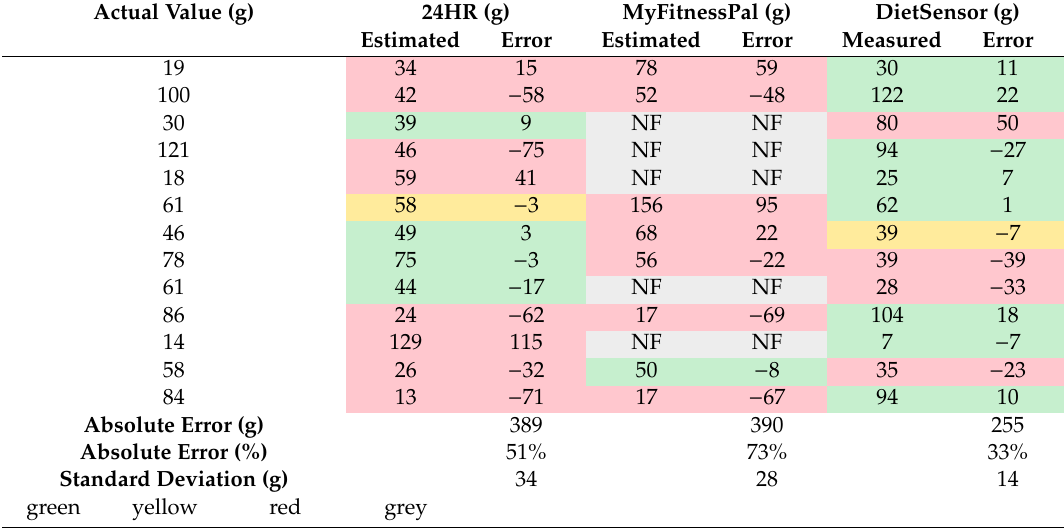
Table 1. The actual volume for each meal, along with the observed and absolute error for each method, in grams (g). For each trial, cells highlighted in green are the best result (lowest error) out of the three methods (DietSensor, 24HR, and MyFitnessPal). Cells highlighted in yellow are results that were not the best but still had an error of less than 10 g, and cells highlighted in red were results with errors above 10 g and did not have the lowest error amongst the three methods. These results contain data from all three groups (A, B, and C). Group C users were not made to use MyFitnessPal (under the assumption that they are not aware of any information about the plate). These cells have been labeled NF (Not Found). Actual Value (g)